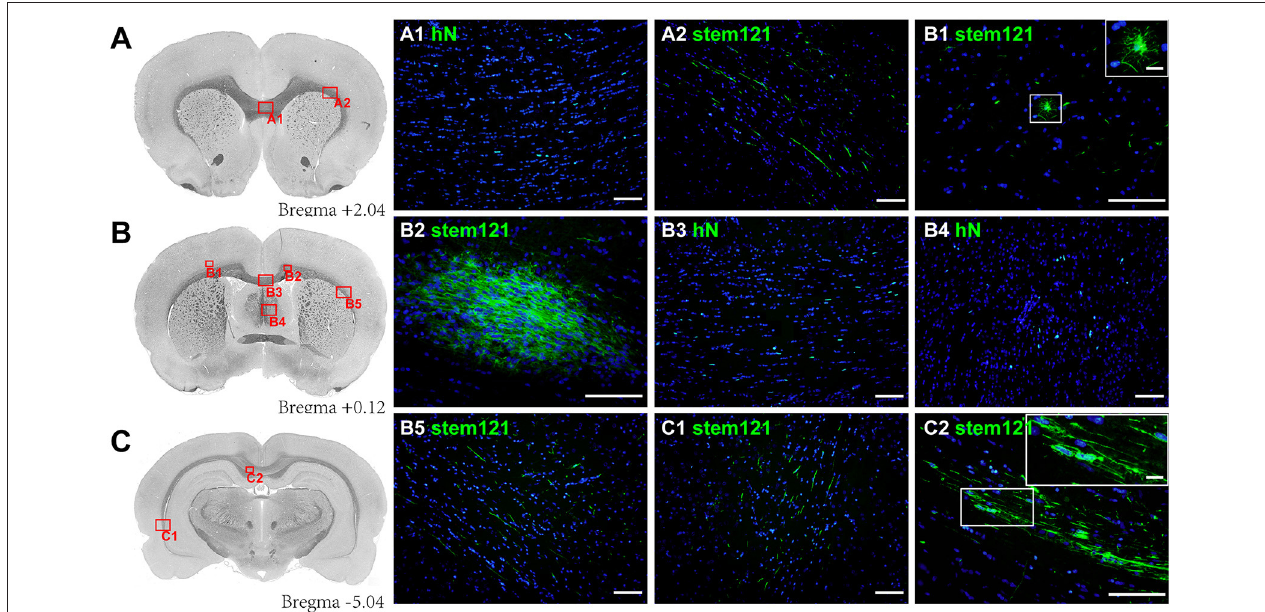
FIGURE 1 | Migration of transplanted hOPCs. (A–C) Stem121 + /hN + cells were widely distributed in the injured white matter and migrated to the contralateral brain in PWMI rats at 13 weeks after transplantation. Stem121 + cells in the lower layers of the cortex were round with extensive and radial processes (B1), while cells in the corpus callosum were spindle-shaped with long parallel processes (C2). All coronal sections were counterstained with DAPI. Scale bar represents 100 µ m in (A1-C2) and 15 µ m in zoomed images of B1 and C2.